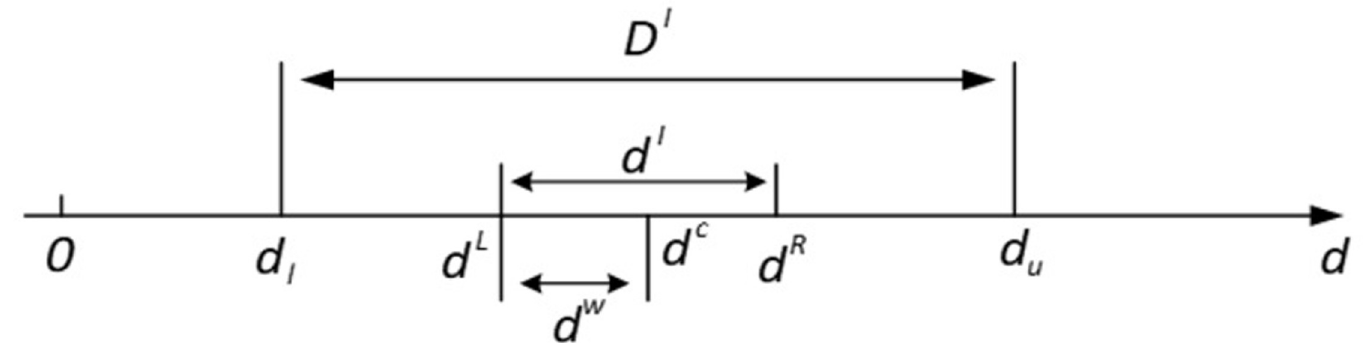
Fig 4. The relationship between interval and design